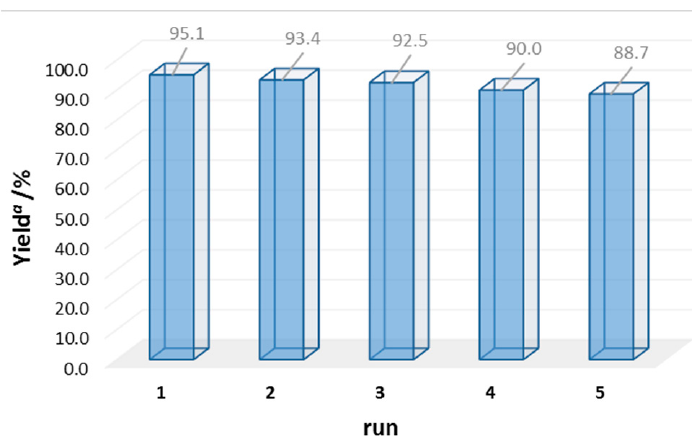
Figure 10. Solvent ‐ free MW ‐ assisted oxidation of 1 ‐ phenylethanol to acetophenone using Figure Fe 3 O 4 @EDTA ‐ Mn 2+ ( 1 ) as catalyst before and after reaction (up to 5 recycles). Reaction conditions: